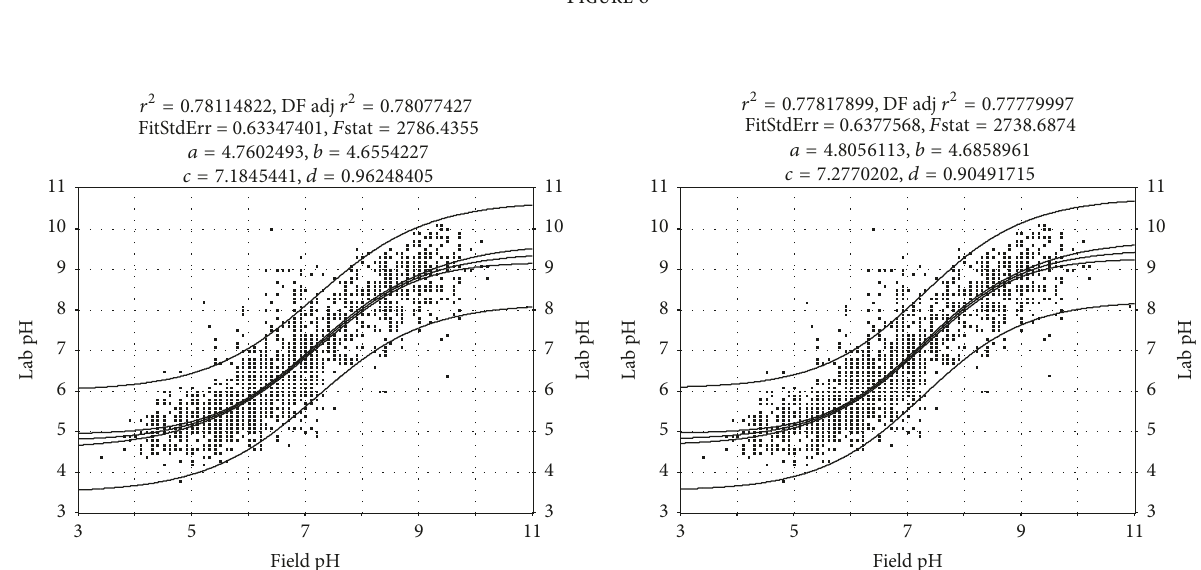
(b) Sigmoid model (original data)for field pH F versus pH W with Pearson minimisation and 95 % CI (narrow band) and 95 % PI (broad band)